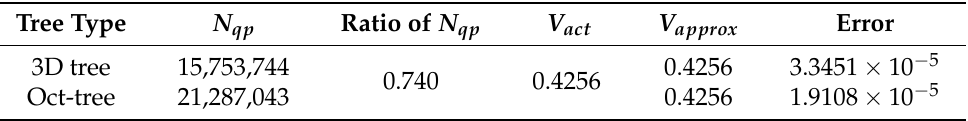
Table 10. Comparison of kd-tree and oct-tree cell division for quadrature cell refinement in a particulate system with 84 spherical